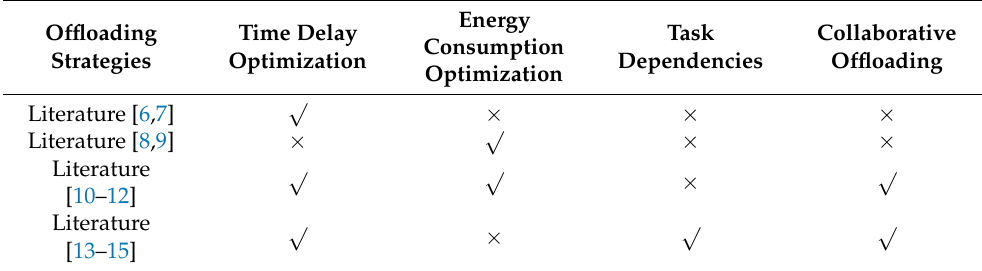
Table 1. Comparison of different offloading